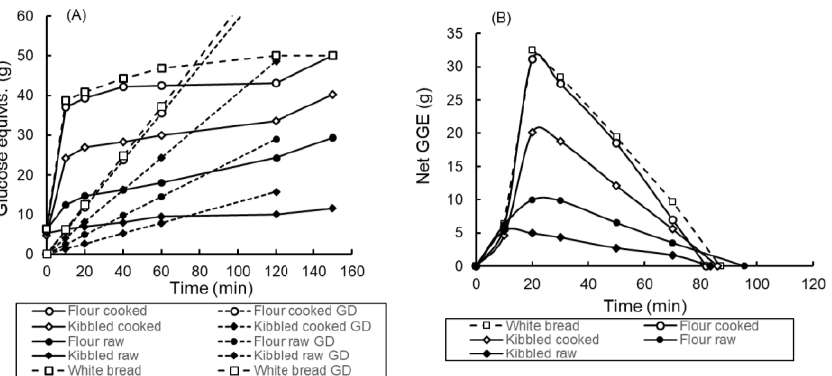
Figure 1. ( A ) Digestogram for porridge samples (all 50 g potentially available carbohydrate) differing in particle intactness and cooking. Samples were homogenised at 120 min and digestion continued to 150 min. Points are means of duplicate samples. Mean absolute deviation from mean = 1.2 g. Glucose disposal (GD) baselines corresponding to each digestion curve are shown. ( B ) Net glycaemic glucose equivalents were determined from the difference between each digestion curve and its corresponding GD baseline in Figure 1A. Potential available carbohydrate content was assumed to be that measured in the cooked homogenised flour sample at 150 min digestion.